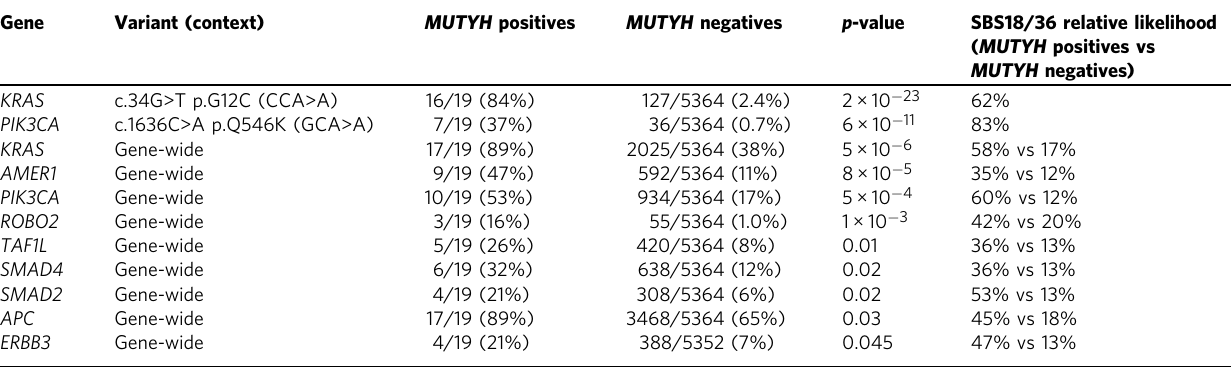
Table 2 Signi fi cantly enriched individual somatic mutations, as well as genes signi fi cantly affected by non-synonymous somatic mutations, observed in more than two MUTYH positive